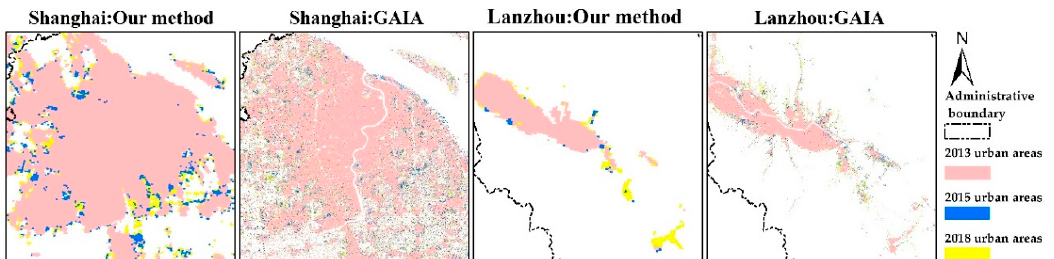
Figure 10. Urban expansion from 2013 to 2018 for Shanghai and Lanzhou.